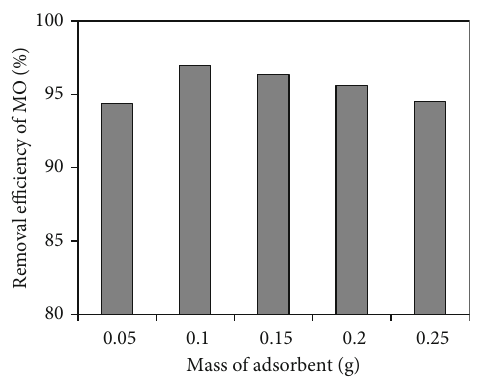
Figure 4: Impact of adsorbent mass on sorption of MO dye on AlgN-CTAB ( ½ MO (cid:2) = 10 mgL − 1 , interactiontime = 60 min , and o T = 27 ° C